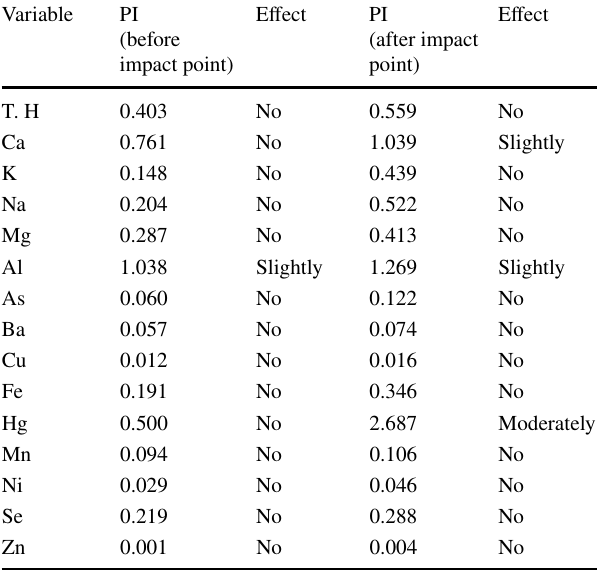
Table 4 Pollution index PI of some water quality parameters and heavy metals for Diyala-Sirwan river with the study area